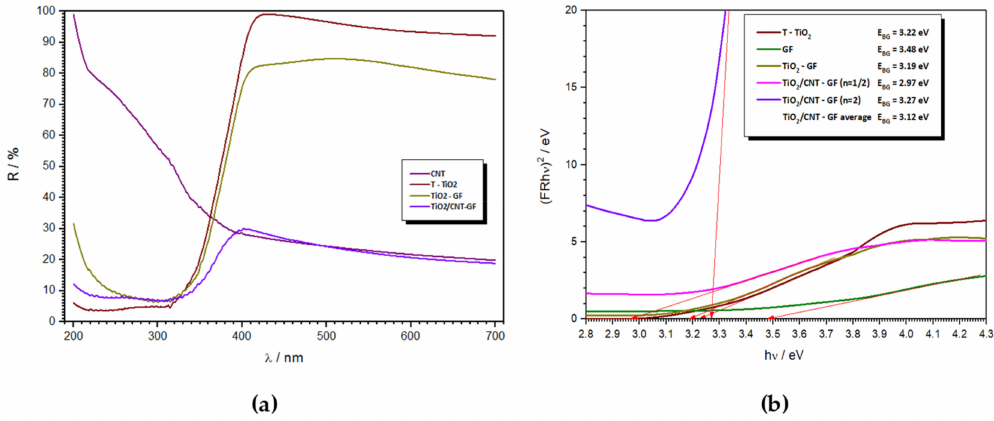
Figure 5. ( a ) DRS UV-VIS spectra ( b ) Tauc plot for the photocatalytic film constituents and photocatalytic composites on glass